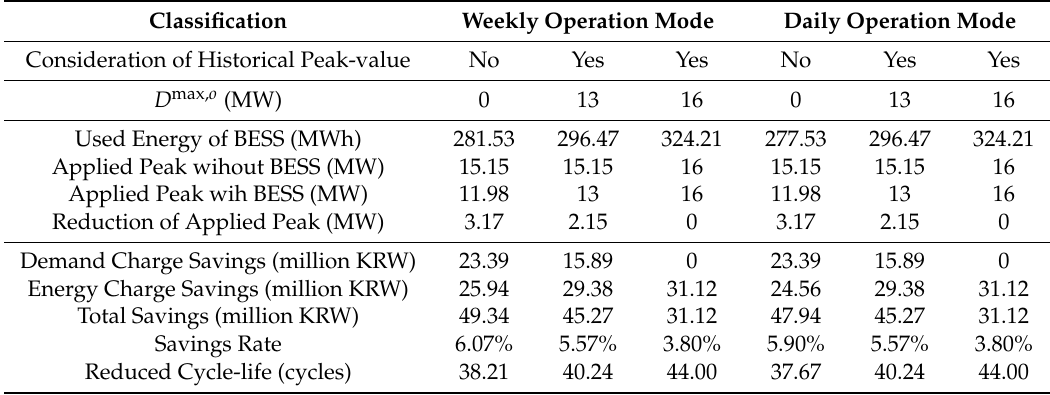
Table 2. Customer’s cost savings for the electric bill minimization during four